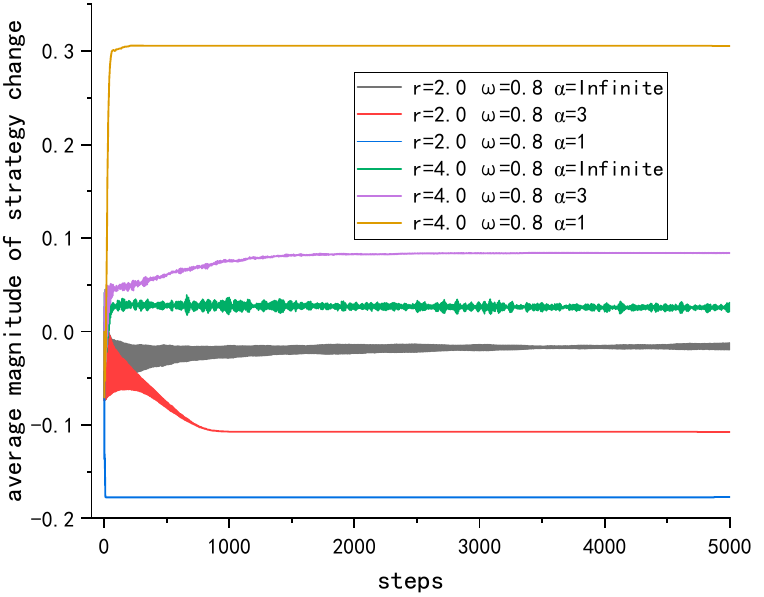
Figure 14. Evolution of the average magnitude of strategy change with time for different combinations of 𝑟 and 𝛼 at 𝜔 = 0.8 .